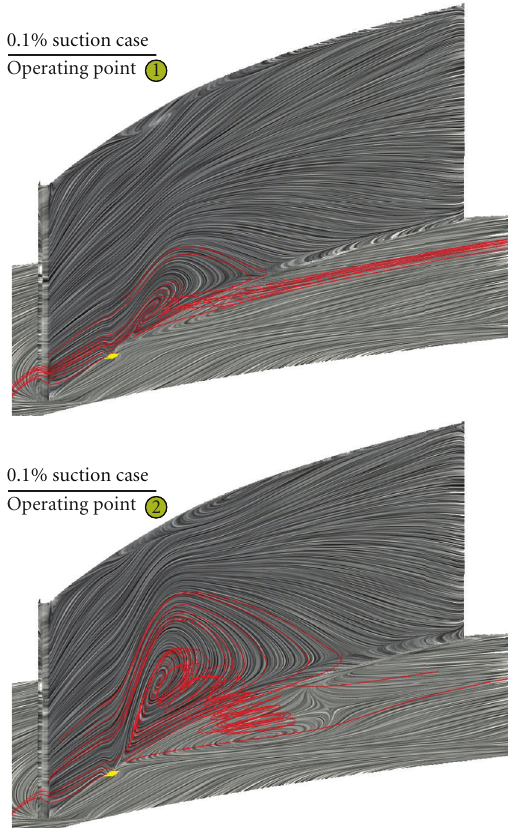
Figure 20: Stall of the 0,1% aspirated di ff